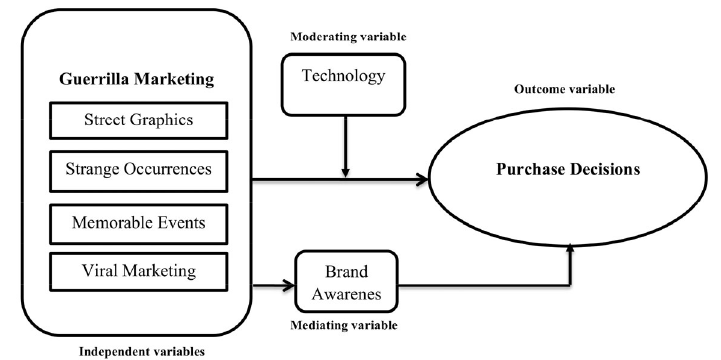
Figure 2. Conceptual framework of the study (source: adapted and modified from previous literature (Hoyer & Brown, 1990; Levinson, 1984; Hutter & Hoffmann, 2011; Carter,